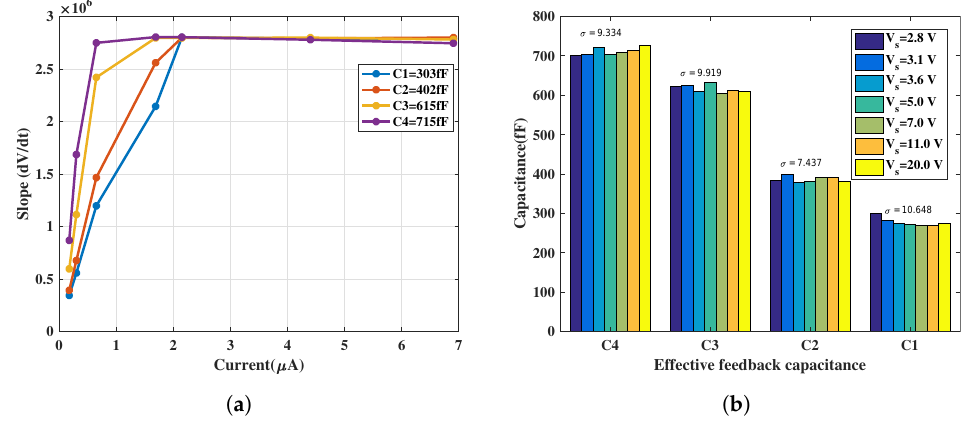
Figure 9. CTIA extracted parameters from transient measurement: ( a ) CTIA slope under higher input currents; and ( b ) variation in measured feedback capacitances (labels as mentioned in Section 3.1.1)